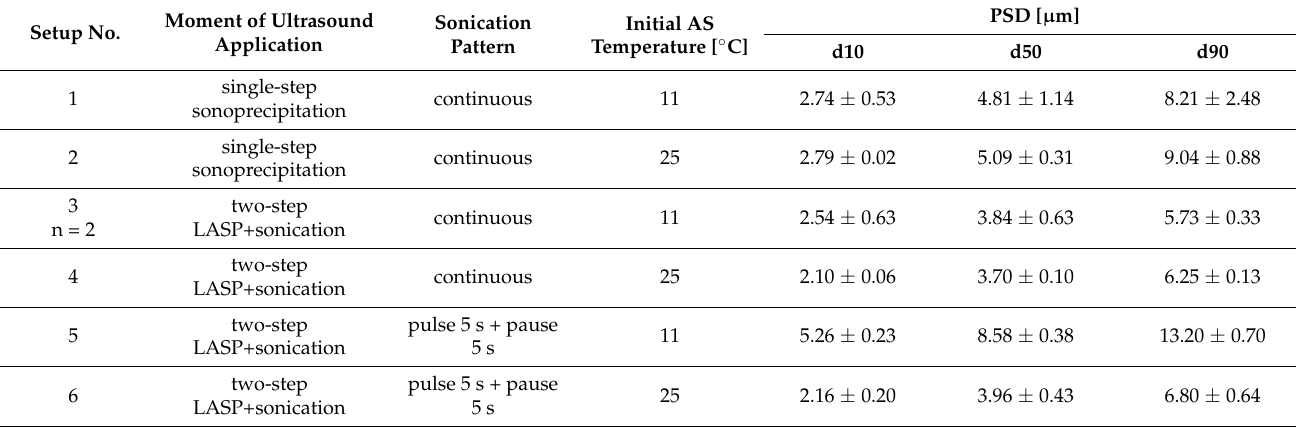
Table 2. Summary of variable combinations and results (mean ± SD) of preliminary sonication studies (n = 3). Setup